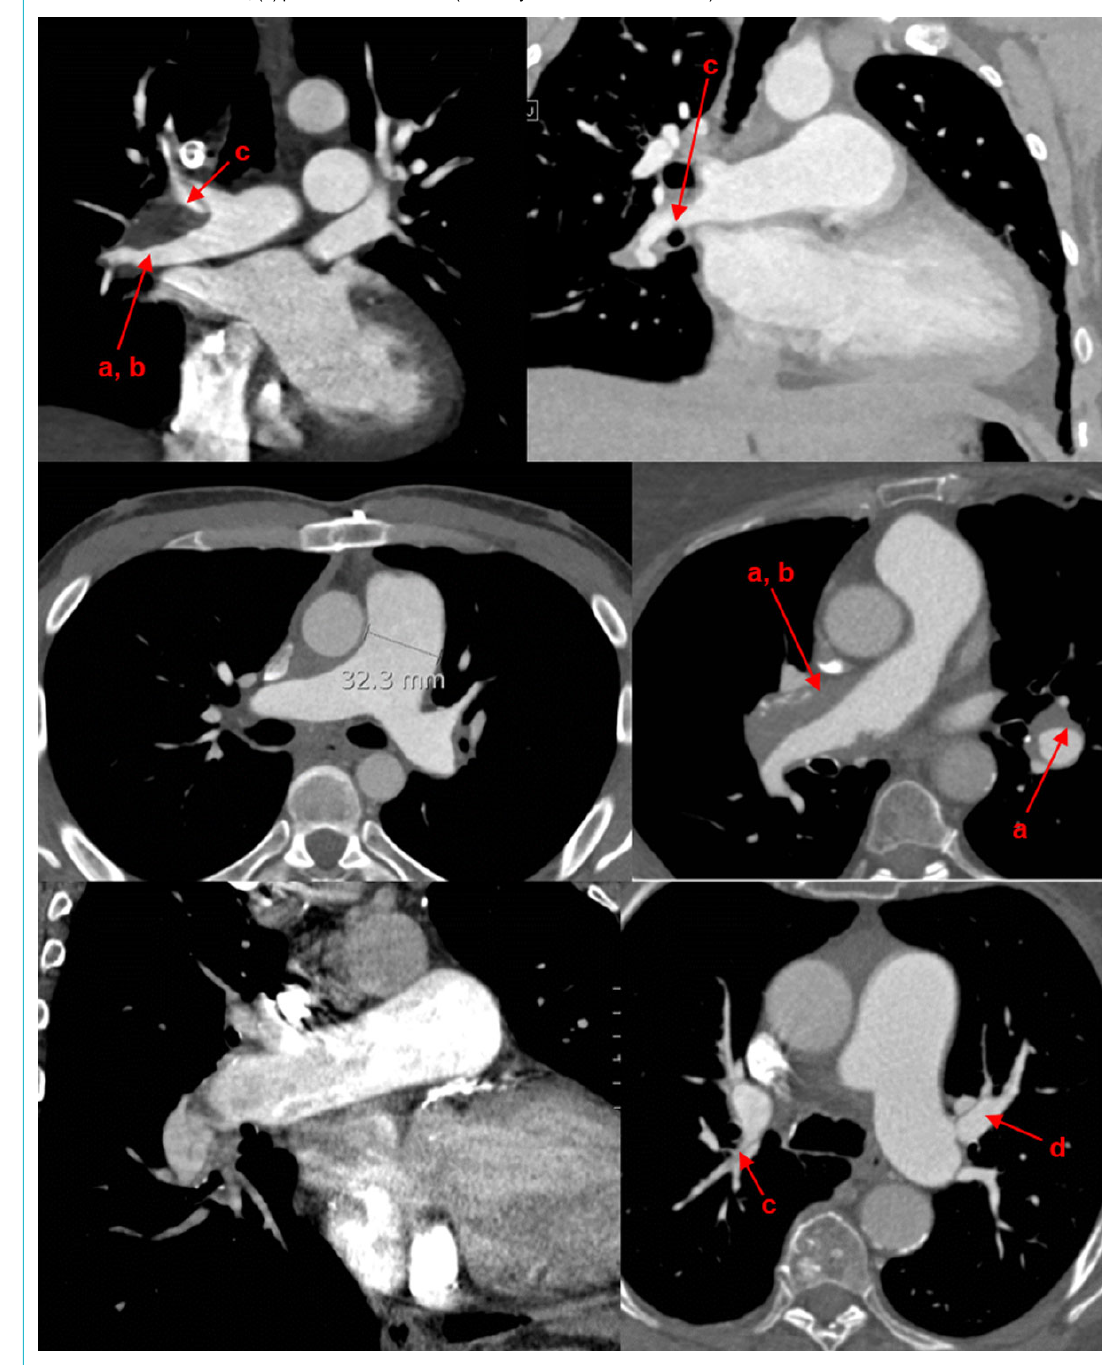
Figure 8: Local vascular characteristics on computed tomography. (a) Partial filling defects, mostly eccentric; (b) organised embolism; (c) in- travascular bands and webs; (d) poststenotic dilatation. (Courtesy of Prof. T.